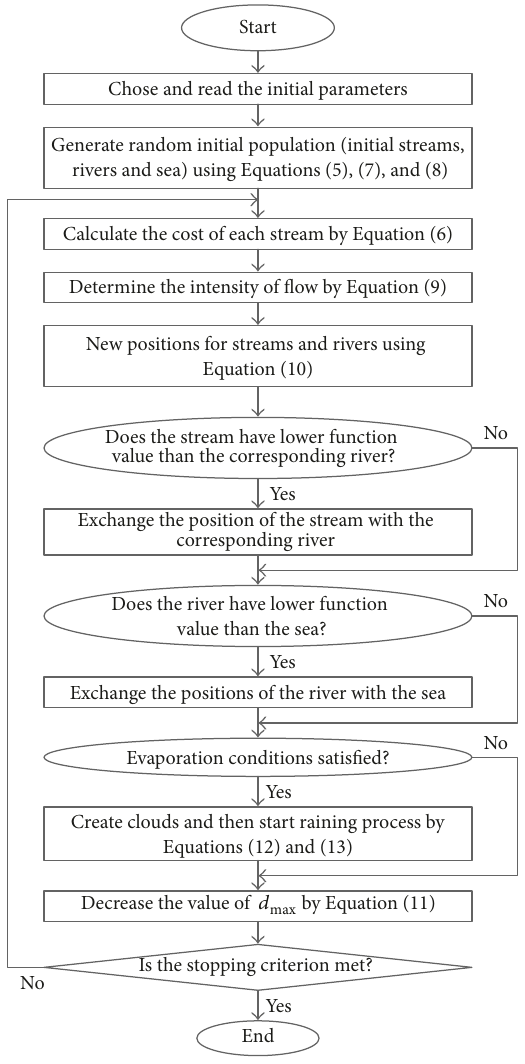
Figure 5: The flowchart of